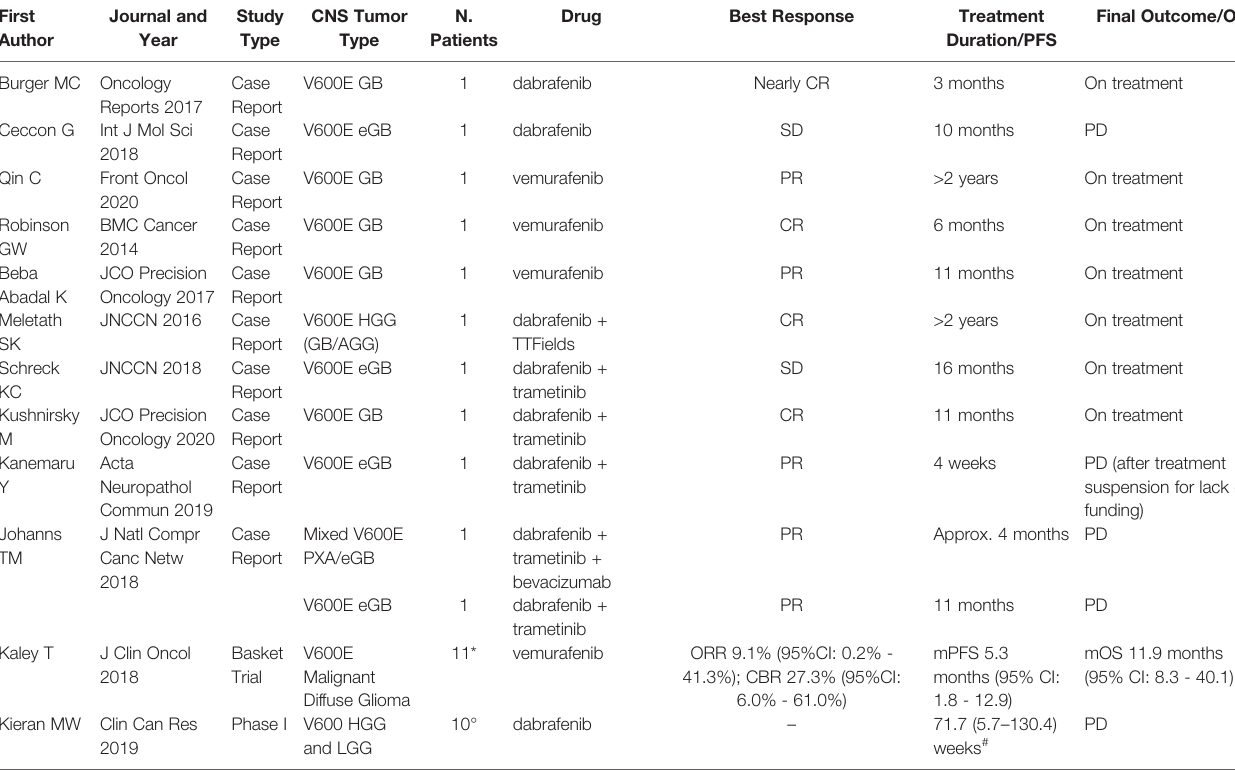
TABLE 1 | Available clinical data on pediatric/adult BRAF -mutant glioblastoma treated with